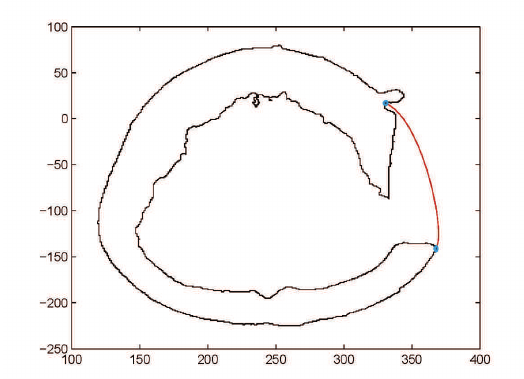
Figure 11. Construction of fractured part curve using C 1 rational Ball curves.